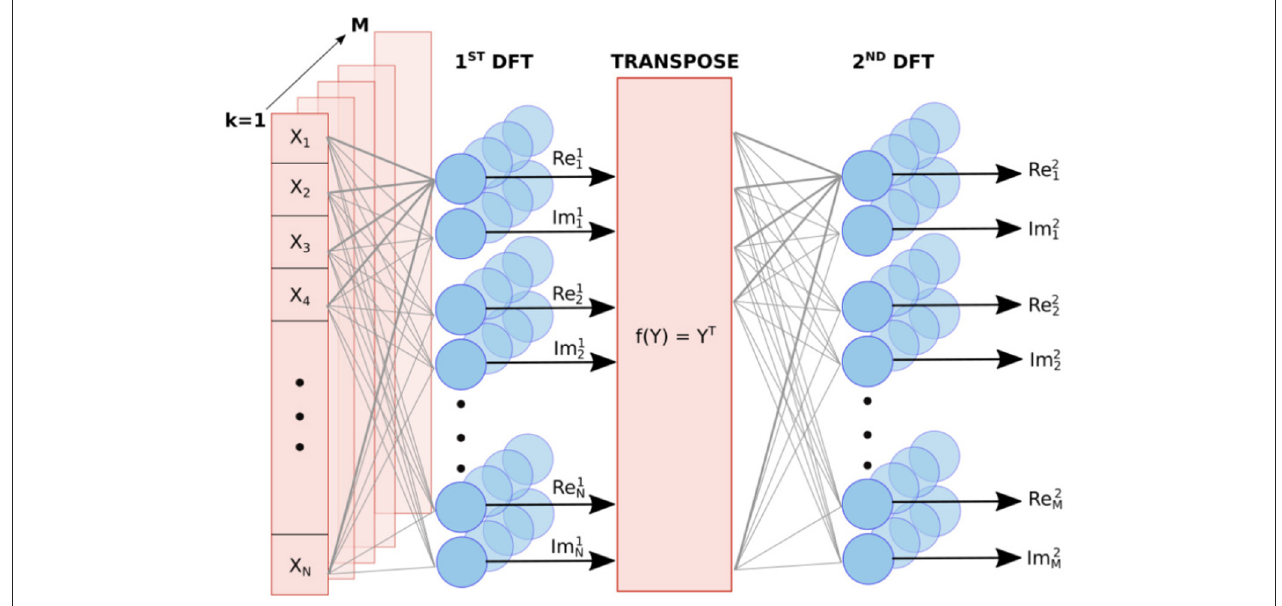
FIGURE 2 | Diagram of the S-DFT. The first layer implements one DFT per chirp to obtain the range-dependent frequency bins, and the second layer performs a DFT along the different chirps to obtain the Doppler frequency components. A transpose operation is implemented between these steps, as each layer is applied along a different